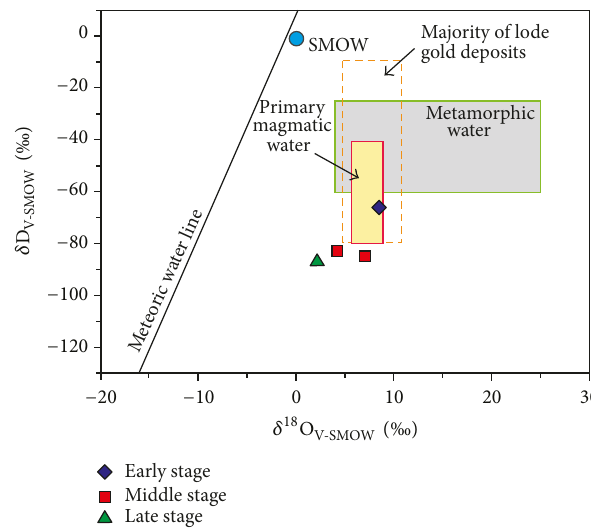
Figure 12: 𝛿 D vs 𝛿 18 O plot of the ore-forming fluids in the Liyuan gold deposit. Also shown are the isotopic fields for common metamorphic and primary magmatic water [30]. The field for orogenic gold deposit revised after Goldfarb et al.